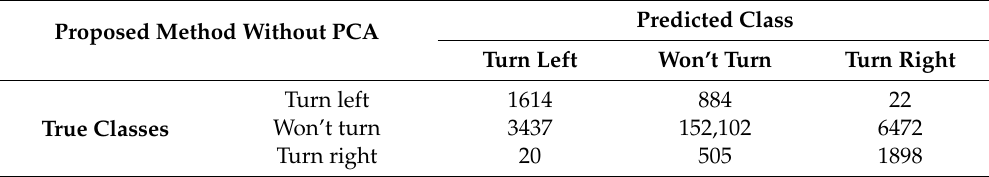
Table 6. The confusion matrix of the proposed method without PCA.